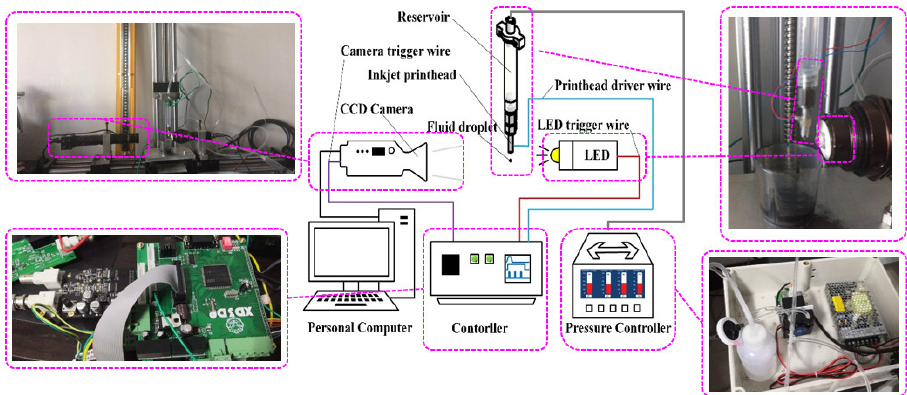
Figure 6. Schematic of the experimental system.